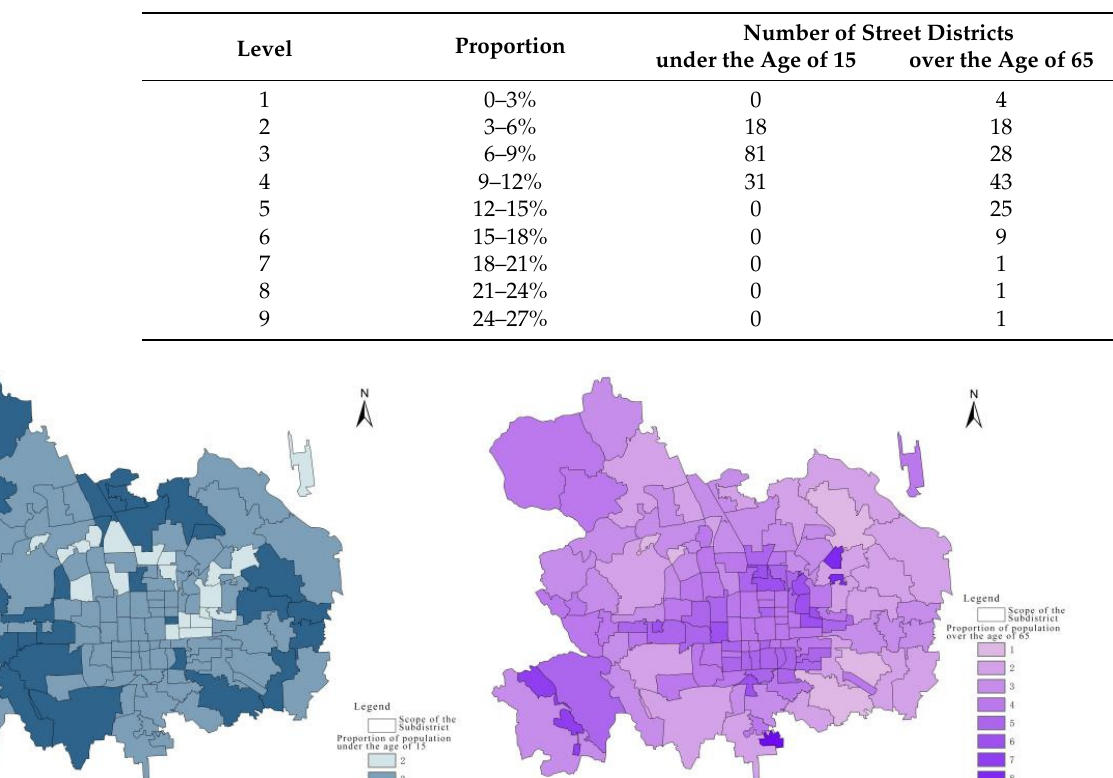
Table 2. Statistics of the young and old population proportion levels.